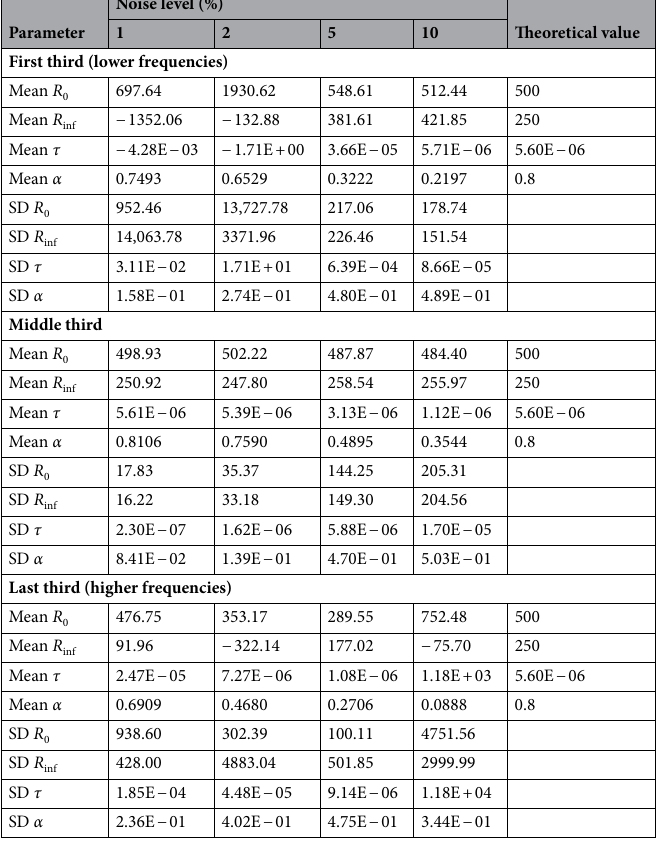
Table 8. Parameters obtained by the 3P method with simulated spectra created with different percentages of added noise. Form 3.